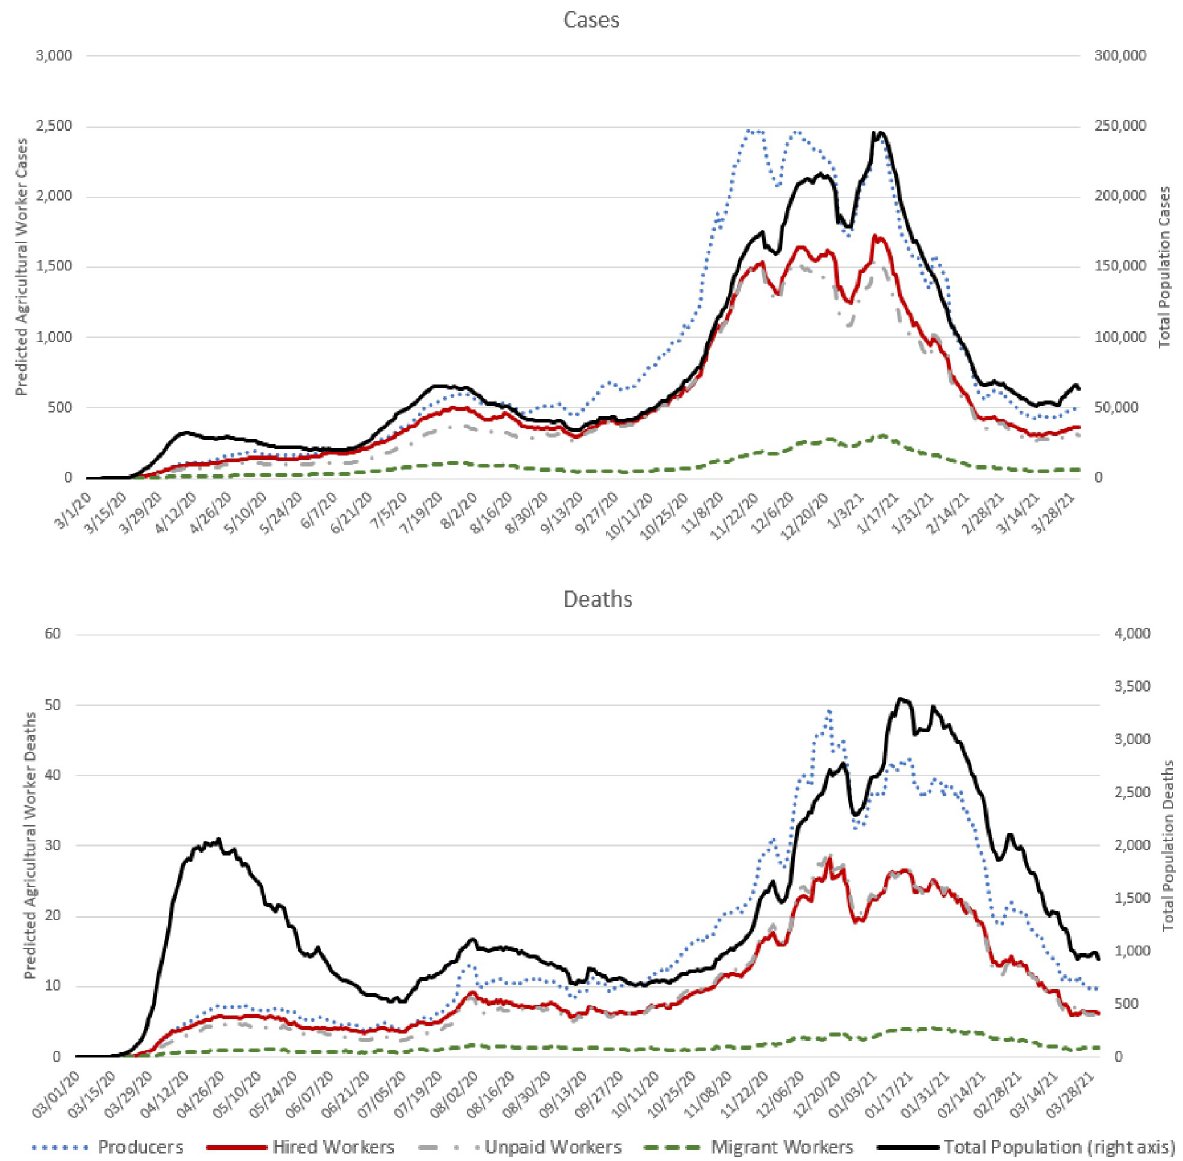
Fig 1. Estimated new daily COVID-19 cases and deaths in United States counties. (the 7-day rolling averages are reported; in the figure reporting total population deaths, outliers on May 18, 2020 (resulting from a few urban New York counties), June 25, 2020 (resulting from a few urban New Jersey counties), and March 12, 2021 were omitted to smooth the trend lines). fewer numbers of agricultural workers. The effects are largest for numbers of hired workers. A 1% increase in the number of hired workers is associated with a 0.04% increase in COVID-19 case incidence and a 0.07% increase in COVID-19 death incidence. Similarly, a 1% increase in the number of migrant workers is associated with a 0.023% increase in COVID-19 case inci- dence and a 0.041% increase in COVID-19 death incidence. As a case in point, at the end of October 2020, the four counties with the largest number of hired workers at that time (Yakima and Grant, Washington and Fresno, Monterey, and Tulare, California) had an average COVID-19 confirmed case incidence rate of 3.57%. By contrast, among the 77 counties with no hired workers, the COVID-19 confirmed incident rate at the same time was only 2.25%.